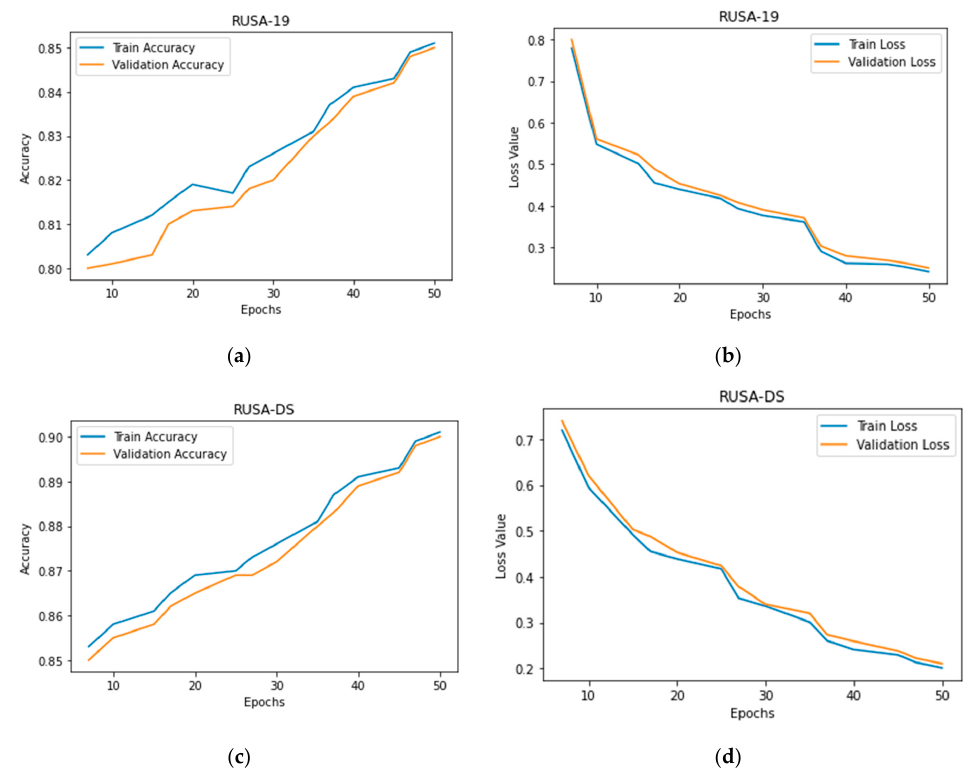
Figure 4. 4C-CNNA evaluation on RUSA-19 and RUSA dataset: ( a ) classification accuracy of RUSA-19 on training and validation samples; ( b ) cross-entropy loss on RUSA-19 for training and validation samples ( c ) classification accuracy of RUSAD on training and validation samples; ( d ) cross-entropy loss on RUSAD for training and validation samples.